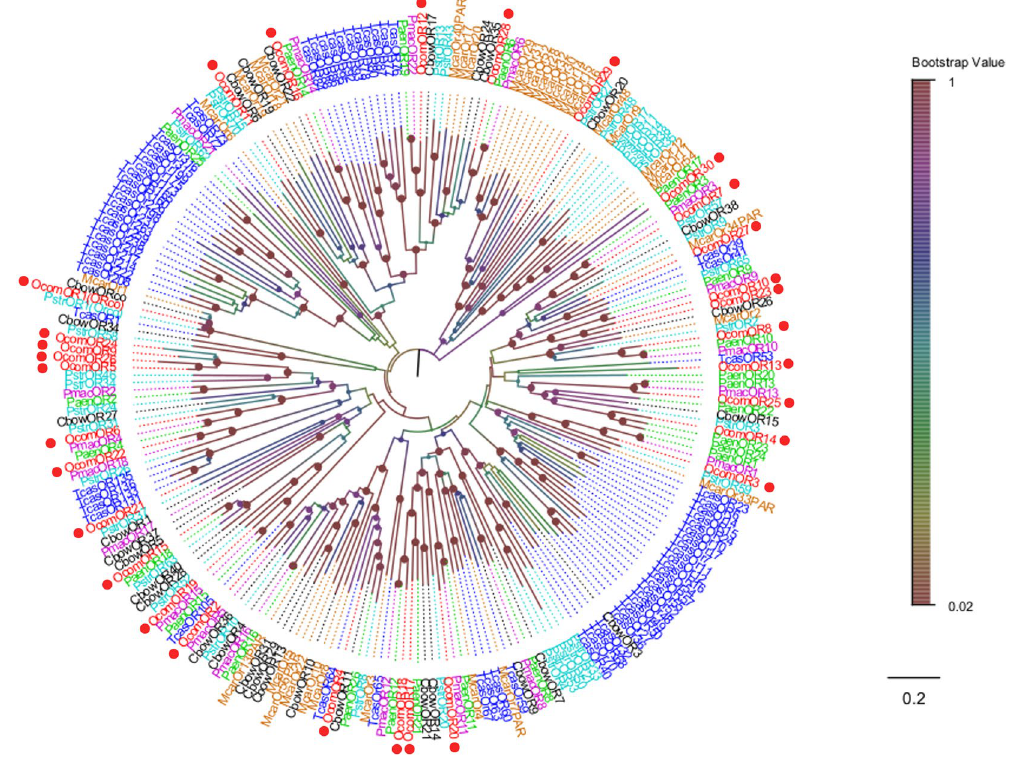
Figure 6. Neighbor joining phylogenetic tree of candidate OcomORs with known Coleopteran OR sequences. Tcas, Tribolium castaneum (N = 70); Pmac, Pyrrhalta maculicollis (N = 18); Paen, Pyrrhalta aenescens (N = 23); Cbow, Colaphellus bowringi (N = 30); Pstr, Phyllotreta striolata (N = 36); Mcar, Megacyllene caryae (N = 34). Candidate OcomORs were indicated by red